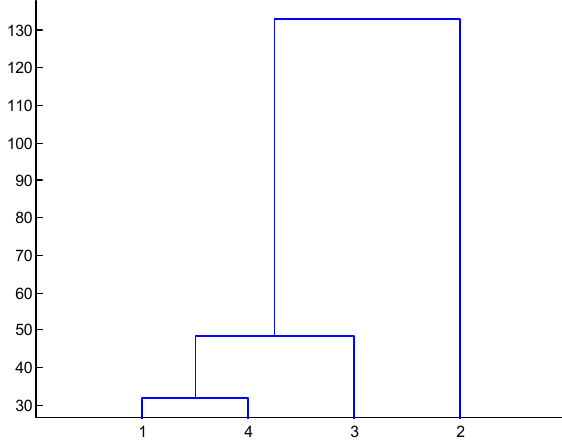
Figure 8. Cluster analysis results of IMFs of IEMD.